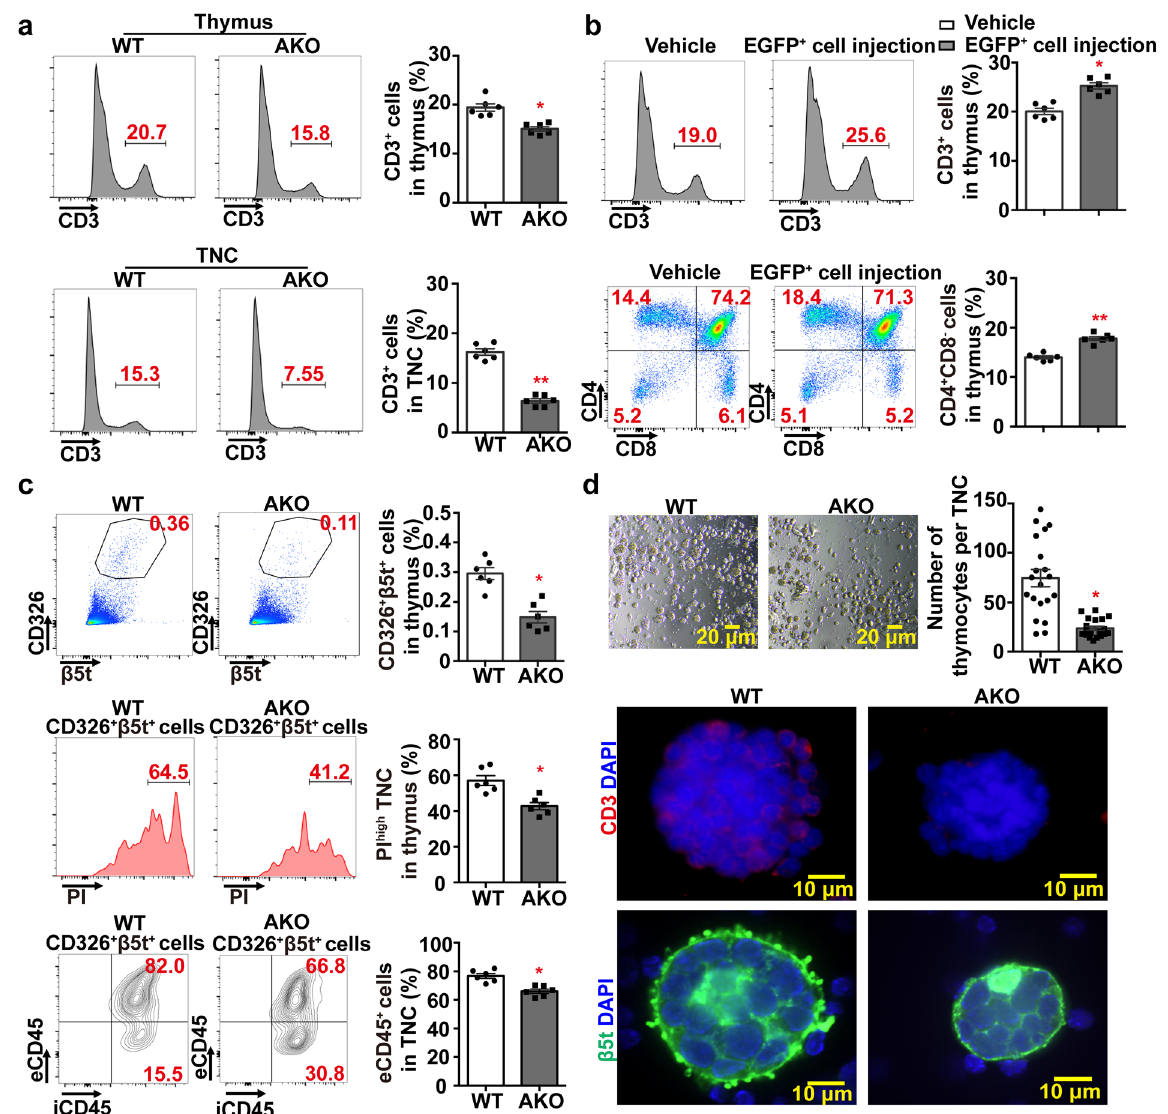
Fig. 8 Adiponectin facilitates T-cell selection and development within the TNC complexes. a WT and AKO mice were sacri fi ced at the age of 6 – 7 weeks. Thymus ( top ) and TNC complexes ( bottom ) were prepared to analyze the percentage of CD3 + cell population by fl ow cytometry. b Four-week-old WT mice were subjected to vehicle treatment or adoptive transfer with EGFP + cells from thymus of Adn-Cre/ROSA mT/mG mice (30000 cells/ mouse via tail vein) as described in the Methods. At 21 days after the injection, thymus was collected and subjected to fl ow cytometry analyses for measuring the percentage contents of CD3 + ( top ) or CD4 + CD8 − ( bottom ) cells. c WT and AKO mice were sacri fi ced as in ( a ) to prepare thymic cell suspensions. Flow cytometry was performed to analyze the total amount of CD326 + β 5t + TNC complexes ( top ), TNC complexes with high expression levels of propidium iodide [PI] ( middle ), or eCD45 + cells attached outside of the TNC complexes ( bottom ). d WT and AKO mice were sacri fi ced as in ( a ) to prepare the thymic cell suspensions enriched with TNC complexes. Inverted microscope was used to visualize and manually count the number of thymocytes within each TNC complex ( top ). Immuno fl uorescence staining was performed to detect CD3 ( middle ) and β 5t ( bottom ) signals in TNC complexes of WT and AKO mice. The slides were counterstained with DAPI. Data are presented as mean ± SEM. *, P < 0.05 and **, P < 0.01 vs corresponding controls ( n = 6 biologically independent samples from different animals of independent